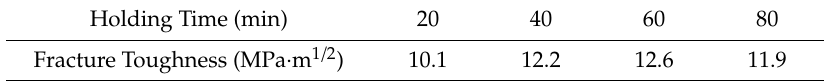
Figure 8. Relative density and Vickers hardness of ultrafine cemented carbides at 1300 °C for different holding times. Table 2. Fracture toughness of ultrafine cemented carbides at 1300 °C for different holding times.